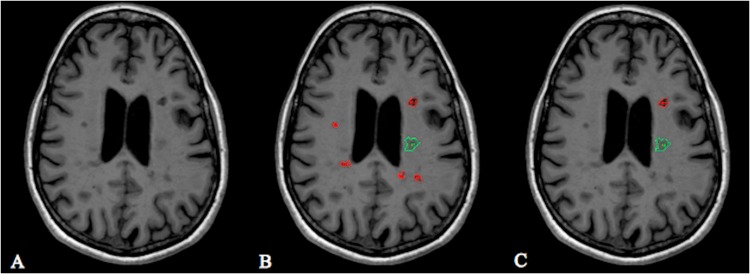
Example of ROI volumes overlaid on T1w images before and after setting a T1-RT threshold.
A: Axial slice of the cerebrum with multiple T1 hypointense lesions. B: Manually placed ROIs without applied threshold: BHvis (red), CE lesion (green). C: Remaining ROIs after applying the obtained optimal threshold of T1-RT >1500 ms with highest correlation to EDDS; CE lesions were not affected by thresholds.